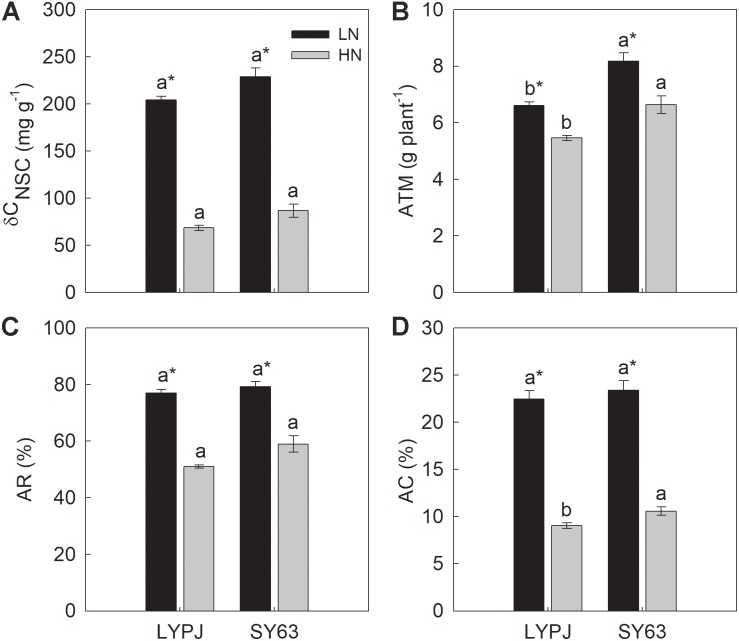
The difference of stem NSC concentrations between heading and at maturity (δCNSC) (A), apparent transferred mass of NSC (ATM) (B), apparent ratio of transferred NSC (AR) (C), and apparent contribution of transferred NSC to grain yield (AC) (D) in LYPJ and SY63 cultivars under LN and HN treatments. Vertical bars represent mean ± standard error (n = 3). Different letters on top of histograms indicate significant differences at P < 0.05 between the two varieties under the same nitrogen condition. ∗Indicates significance at P < 0.05 between LN and HN for the same cultivar.